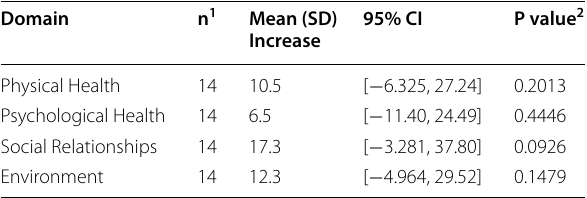
1 Excludes one participant with score over 2 standard deviations above the